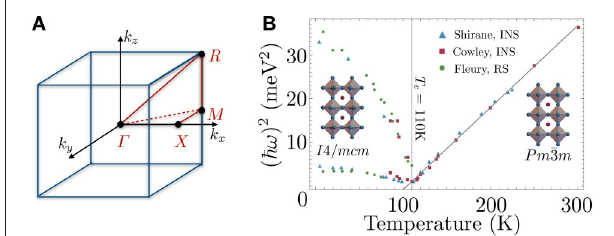
FIGURE 4 | (A) The cubic Brillouin zone indicating the high-symmetry reciprocal lattice points Ŵ , X , M and R . (B) R -point mode softening on the approach to the T c ≃ 110K structural transition in SrTiO 3 , measured from neutron (Cowley et al., 1969; Shirane and Yamada, 1969) and Raman (Fleury et al., 1968) scattering. Black line for T ≥ T c shows agreement with the predicted soft-mode frequency for a dynamically driven second-order phase transition as given in Equation (1).